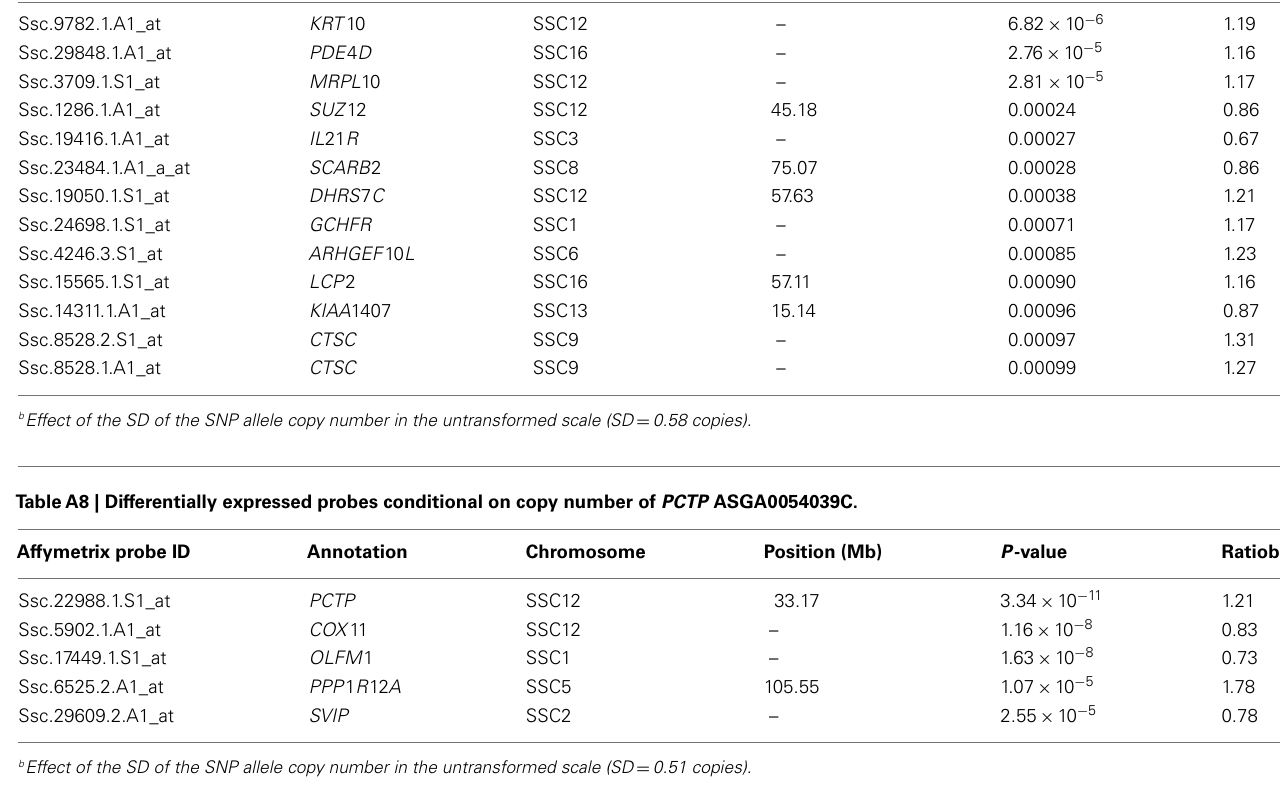
b Effect of the SD of the SNP allele copy number in the untransformed scale (SD = 0.51